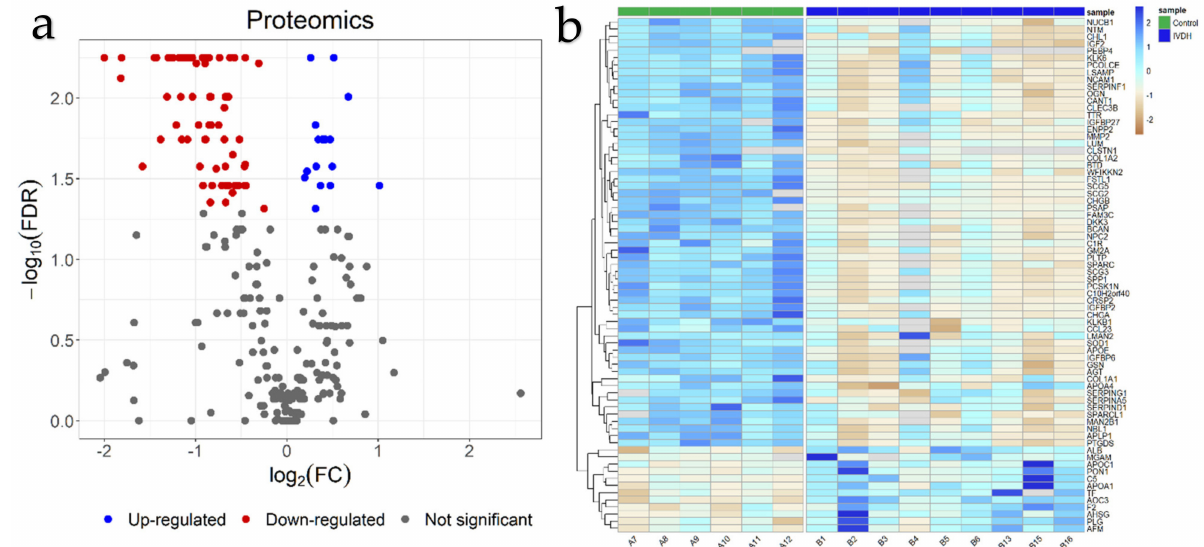
Figure 1. Statistical analysis of proteomics results: ( a ) Volcano plot of evaluated groups after false discovery rate (FDR) correction. Proteins overexpressed in intervertebral disc herniation (IVDH) group are in red, lower-expressed are in blue. ( b ) Heatmap revealing the differentially expressed genes in the control and intervertebral disc herniation groups. Each row represents the fold change (FC) expressed as log2FC of a single gene across all samples. Figure 1b is also available within Supplementary Files for detailed insight (Supplementary Figure S9).